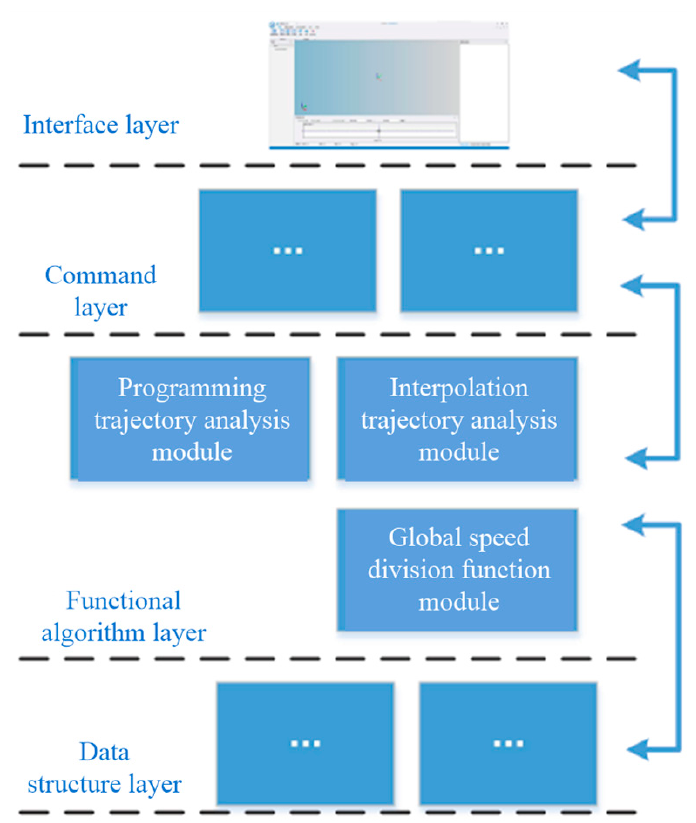
Figure 4. Software Figure 4. Software architecture.